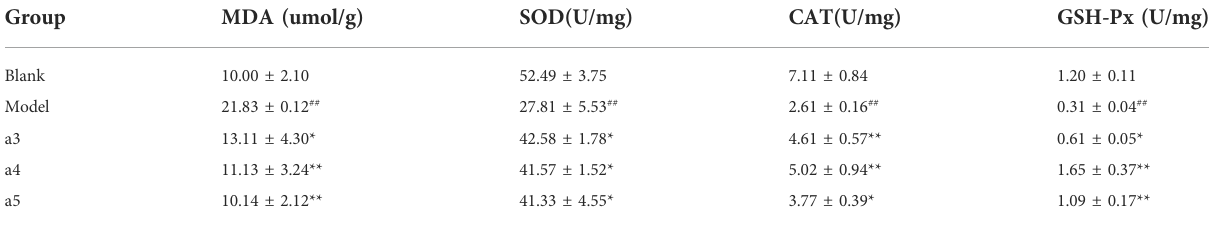
TABLE 3 Effect of 3 key active ingredients on the changes of MDA and antioxidant enzyme activity in hippocampus of App/PS1 mice.